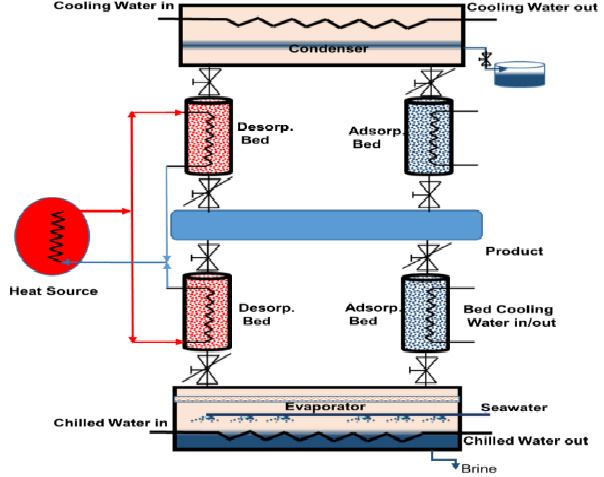
Figure 15. Two-stage ADD system.